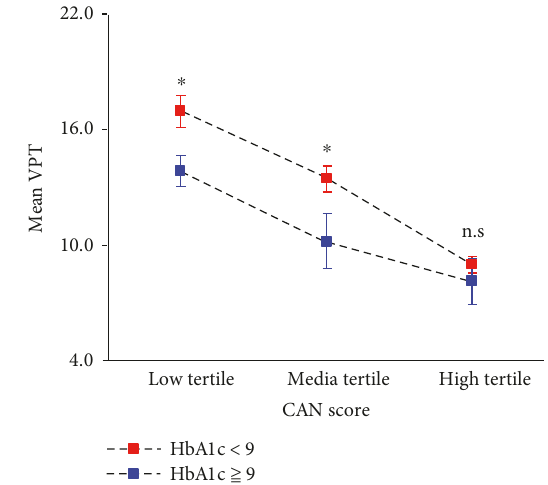
Figure 1: Mean VPT values across the CAN value tertiles, strati fi ed by HbA1c status. Error bars represent 95% CI of the mean. n.s: not signi fi cant. ∗ P value < 0 05